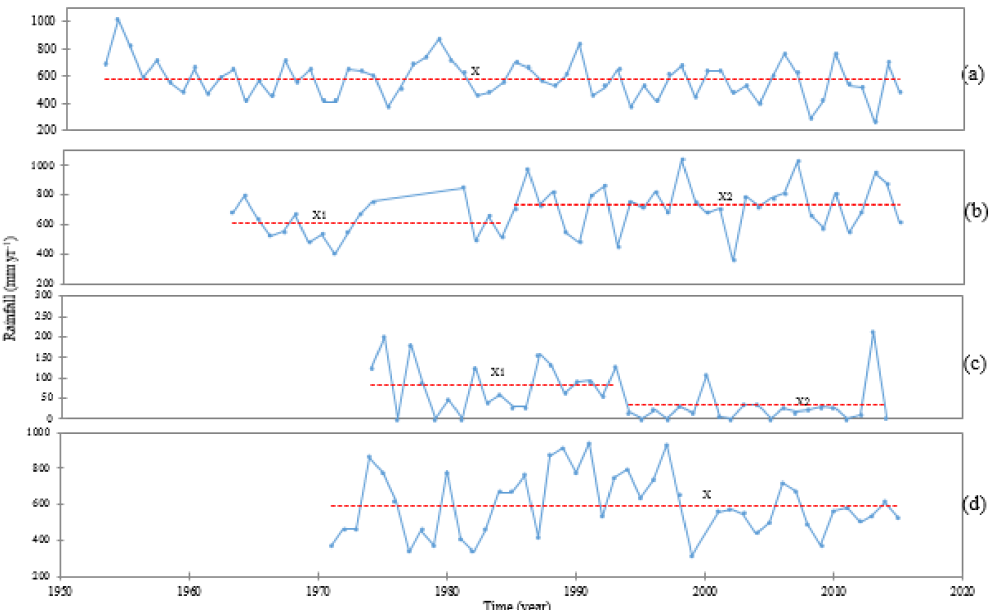
Figure 4. Pettitt homogeneity test of selected rainfall stations (a) annual rainfall in Mekelle (AP), (b) annual rainfall in Axum, (c) short rainy season in AbiAdi and (d) annual rainfall in Adigrat. X 1 and X 2 are average values of rainfall before and after change point.